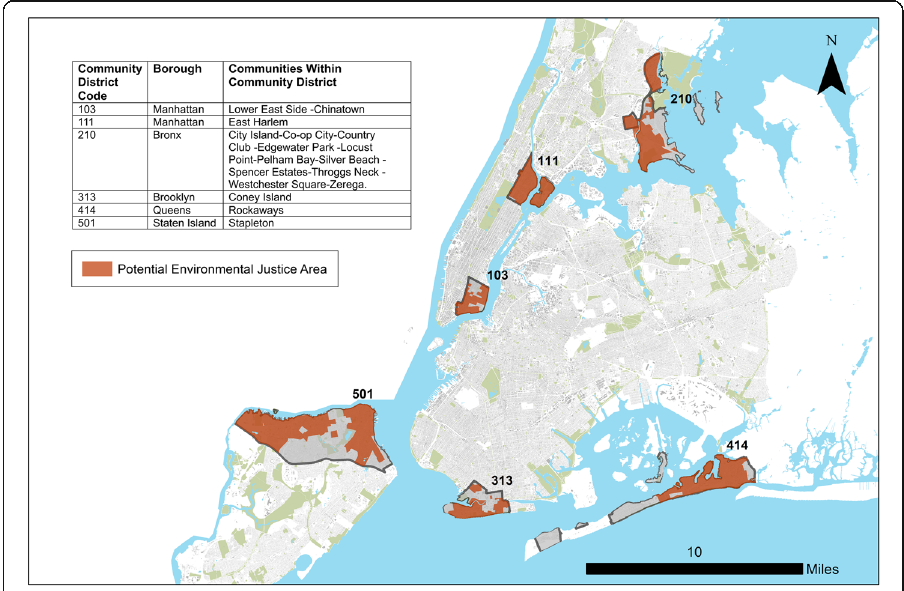
Fig. 1 Location of the NYC CDs selected for this study, their corresponding codes, boroughs, communities contained within them and the portion that is considered a Potential Environmental Justice